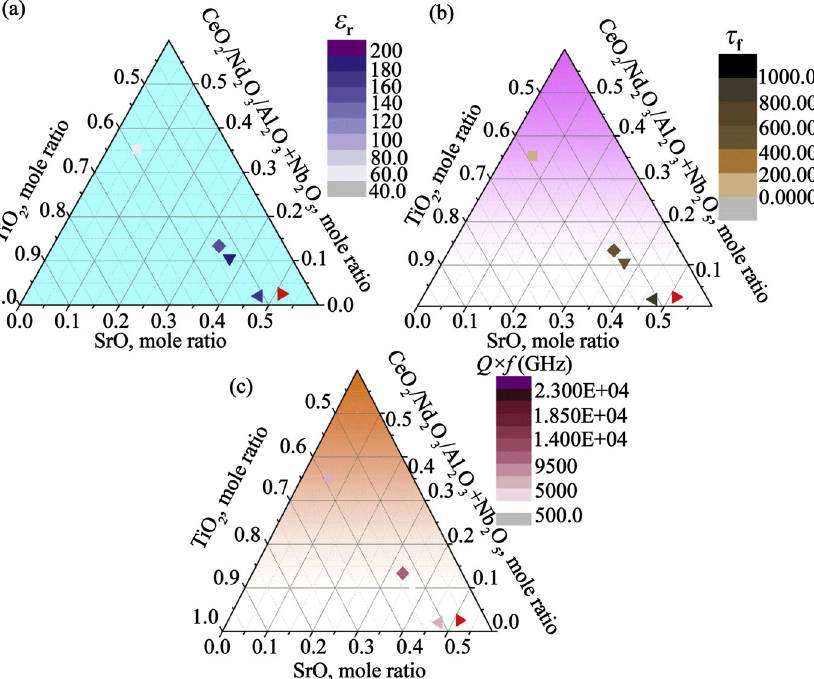
Fig. 19 Compositional dependence of microwave dielectric characteristics of Nd 2 O 3 , CeO 2 , Al 2 O 3 , and Nb 2 O 3 doped SrTiO 3 compound sintered in air, closed pipe, and nitrogen atmosphere with (a) relative permittivity ( ε r ), (b) TCF ( τ f ), and (c) Q × f value, respectively. Reproduced with permission from Ref. [426], © The Chinese Ceramic Society